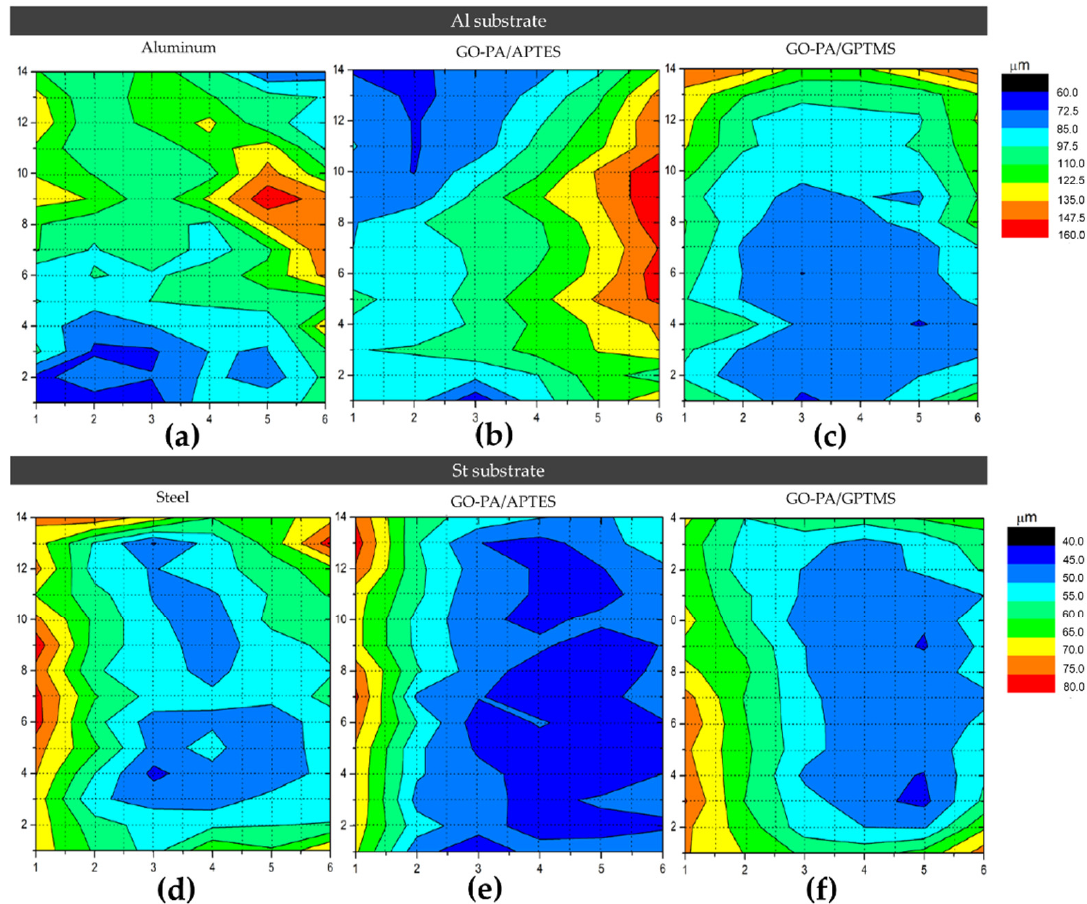
Figure 15. A 14 × 6 grid chromatic map of the metallic specimens in AQ-36 aluminum ( a – c ) and QD-36 steel ( d – f ) coated with paint.